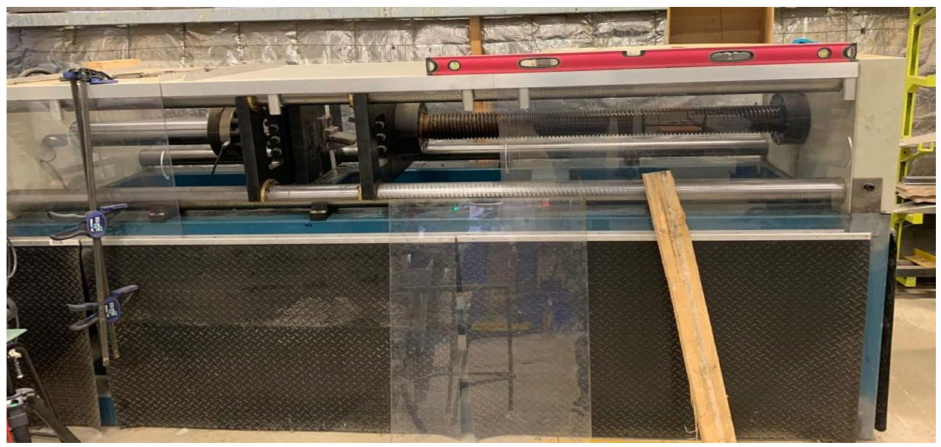
Figure 9. Hydraulic horizontal testing frame 1000